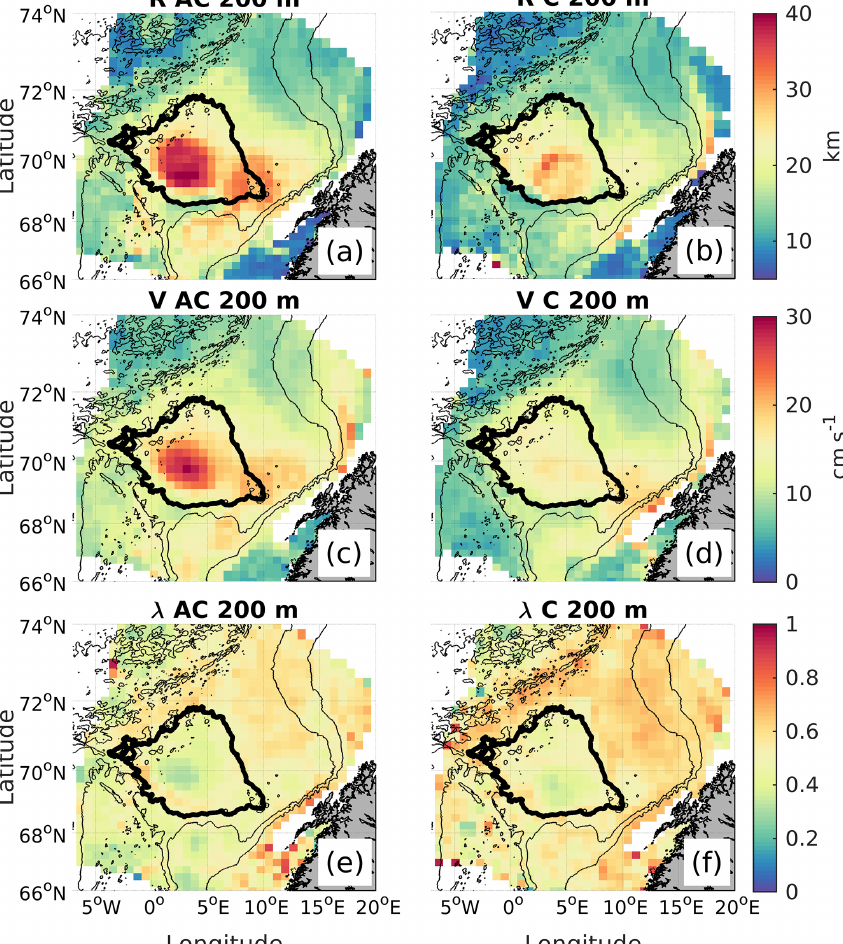
Figure 7. Averaged (a, b) mean geometric radius (km), (c, d) orbital velocity (cms − 1 ) and (e, f) ellipse linearity for (a, c, e) anticyclonic and (b, d, f) cyclonic ridges from 3D drifters deployed at 200m. Bin sizes are as in Fig. 6. Thin black contours show the 1000 and 2000m isobaths and the thick black contour indicates the LB approximated by the 3000m isobath. Note that V in (c) is negative but plotted with opposite sign for better